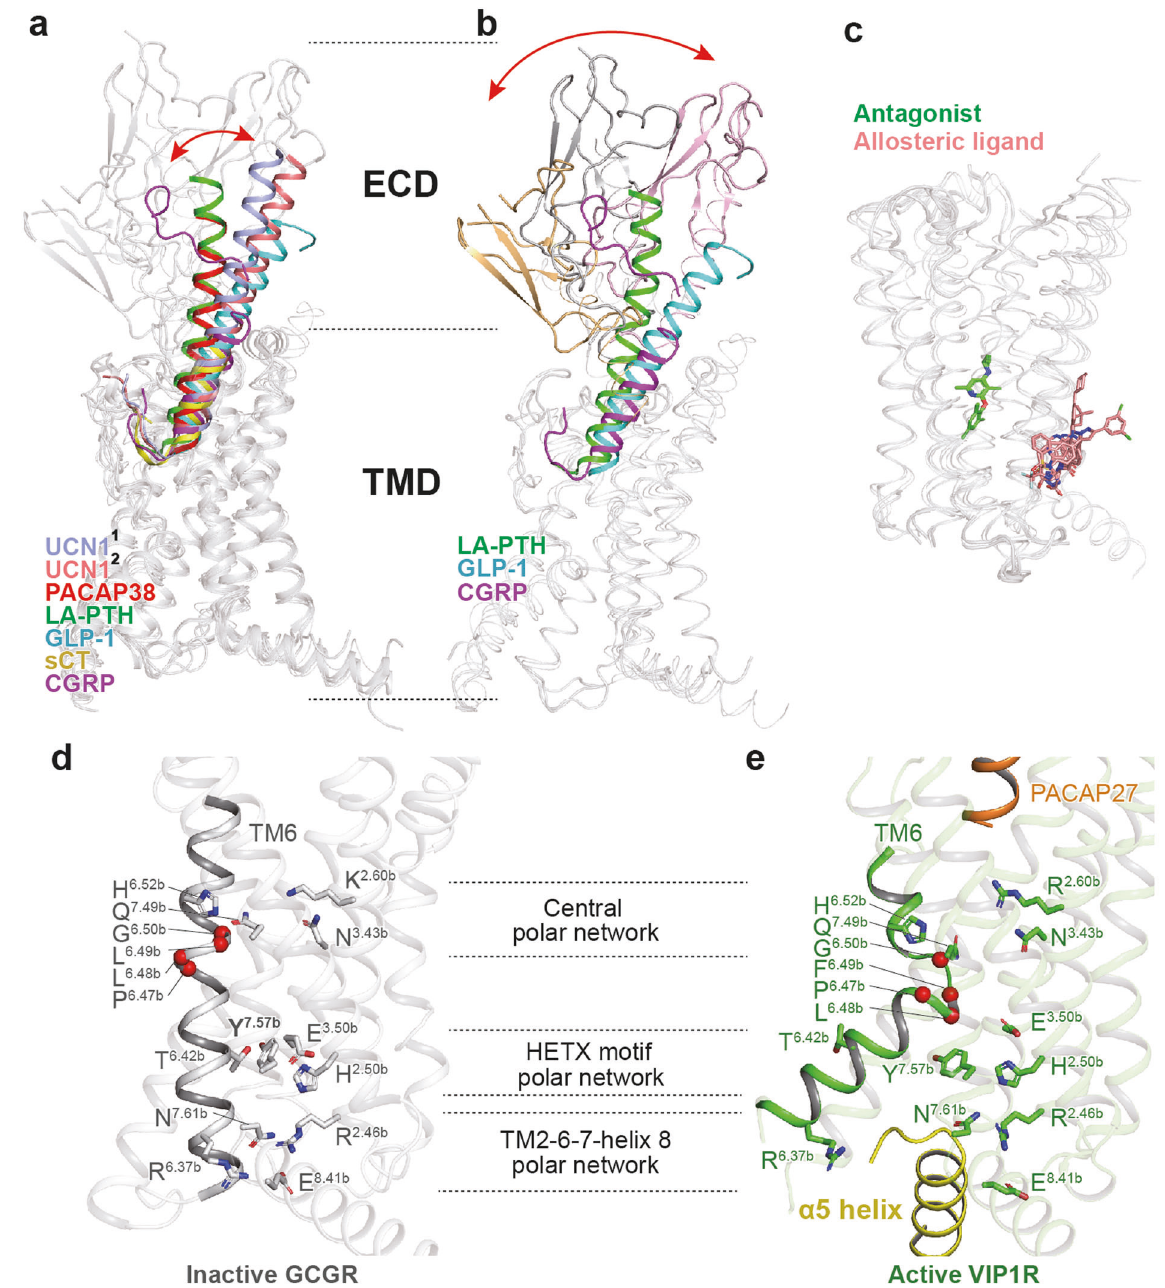
6PB0), UCN1 2 bound to CRF2R (salmon, PDB code: 6PB1), PACAP38 (red, PDB code: 6P9Y), long-acting PTH (LA-PTH, green, PDB code: 6NBF), GLP-1 (cyan, PDB code: 5VAI), sCT (yellow, PDB code: 6NIY), and CGRP (magenta, PDB code: 6PB1) are shown as cartoons. Binding poses of the antagonist (green) and allosteric ligand (salmon) are shown as sticks ( c , PDB codes: 4K5Y, 5EE7, 4Z9G, 5VEW, and 5VEX). d , e The common activation mechanism of class B GPCRs as exampled by the structures of inactive GCGR (gray, PDB code 3NYA) and active VIP1R (green, PDB code 6VN7). Side chains of residues in three conserved polar network are shown in stick presentation. The conserved P 6.47b xxG 6.50b motifs in TM6 are shown as single red